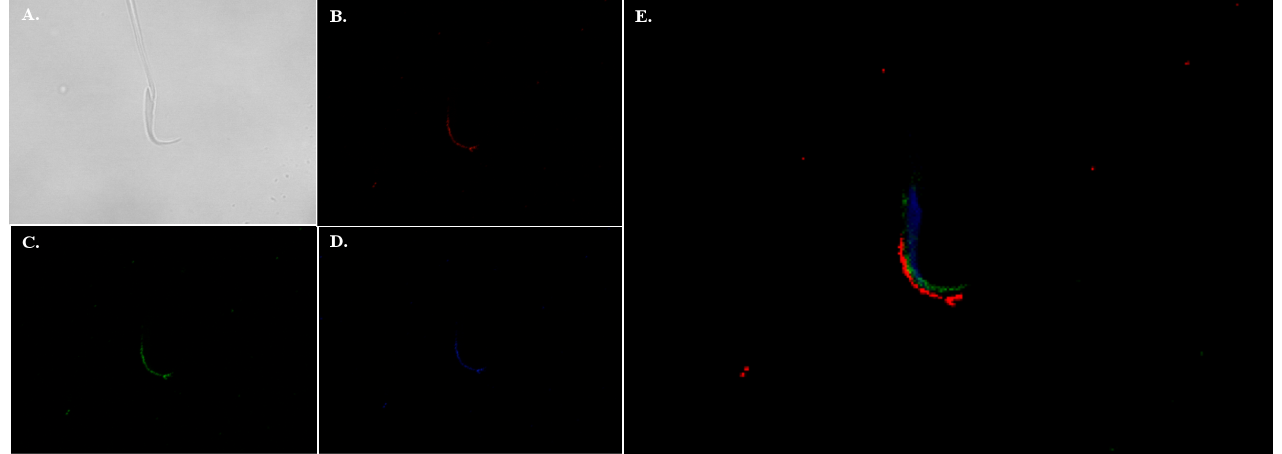
Figure 6. Immunolocalization of NHE11 in mature rat sperm. Immunolocalization of NHE11 in mature rat sperm cell was performed with our anti-NHE11 antibody. ( A ) DIC image of the rat sperm cell. ( B ) Anti-NHE11 immunofluorescence (red). ( C ) PNA-FITC staining of the acrosome (green). ( D ) DAPI staining of cell nucleus (blue). ( E ) Merged image of the three color channels ( B – D ). NHE11 appears to localize to the plasma membrane overlaying the acrosomal region in mature rat sperm cells. Images were taken on a Zeiss LSM 710 confocal microscope with a 63× objective.